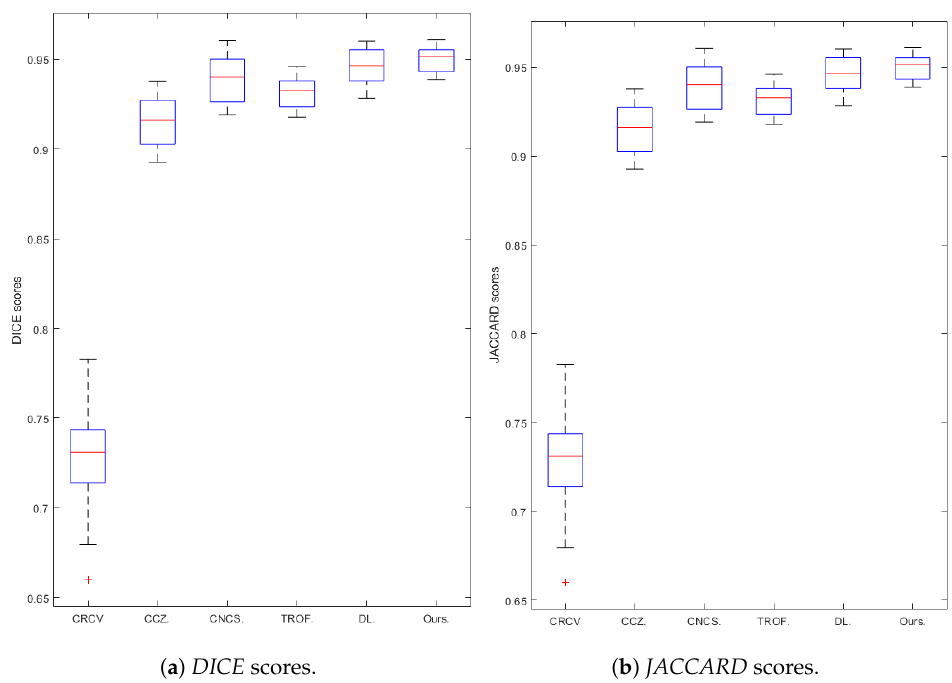
Figure 10. Comparison of six methods (CRCV, CCZ, CNCS, TROF, DL, Ours): box plots of the quantitative results for DICE ( a ) and JACCARD ( b )